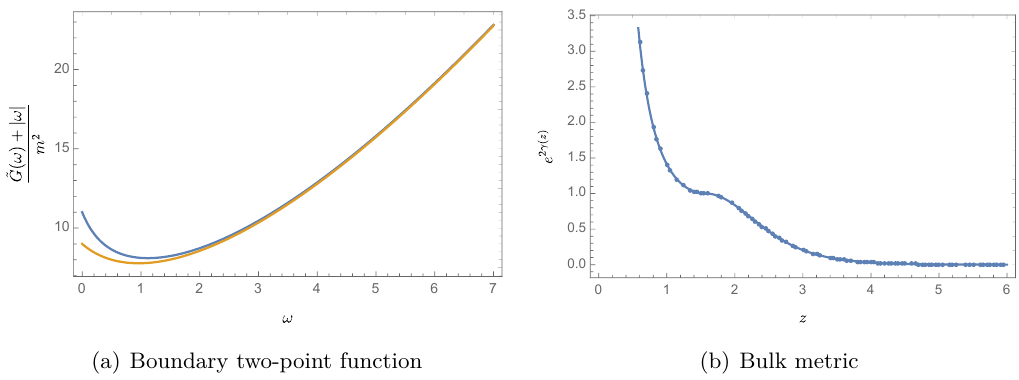
Figure 4 . (a) Correction to the boundary two-point function for the centaur geometry in blue and the AdS black hole in yellow ( e 2 γ ( z ) = sinh − 2 z ). We see both curves rapidly overlapping 2 as ω grows larger, while differences appear for small- ω . z = 0 . 1 in the plot. (b) The metric of c the centaur geometry as a function of bulk coordinate z . The blue dots are the numerical metric reconstruction from the boundary two-point function in (B.2), while the solid curve is the exact plot of the metric in